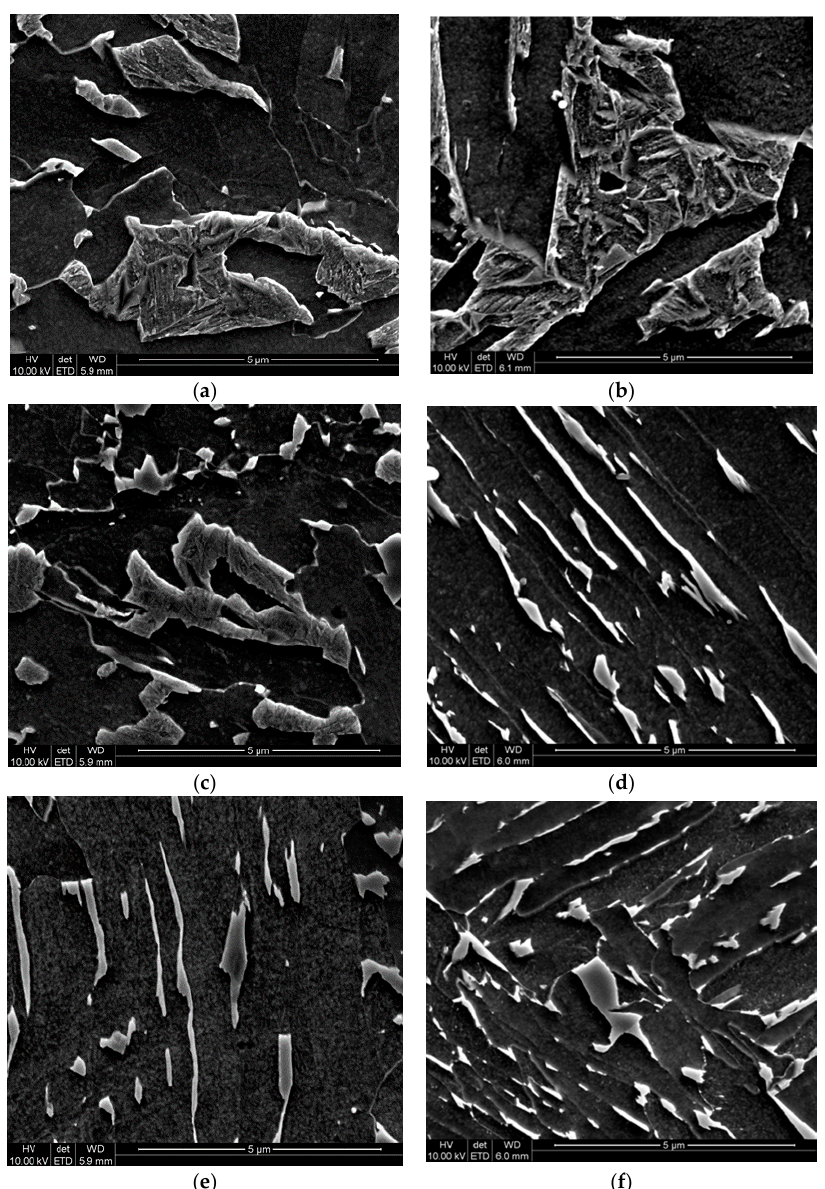
Figure 4. Sample images of the microstructure for heat S405 ( a , c , e ) and S406 ( b , d , f ) at plane strain compression (PSC) deformation, variant 1a ( a , b ), variant 1b ( c , d ), and variant 1c ( e , f ).